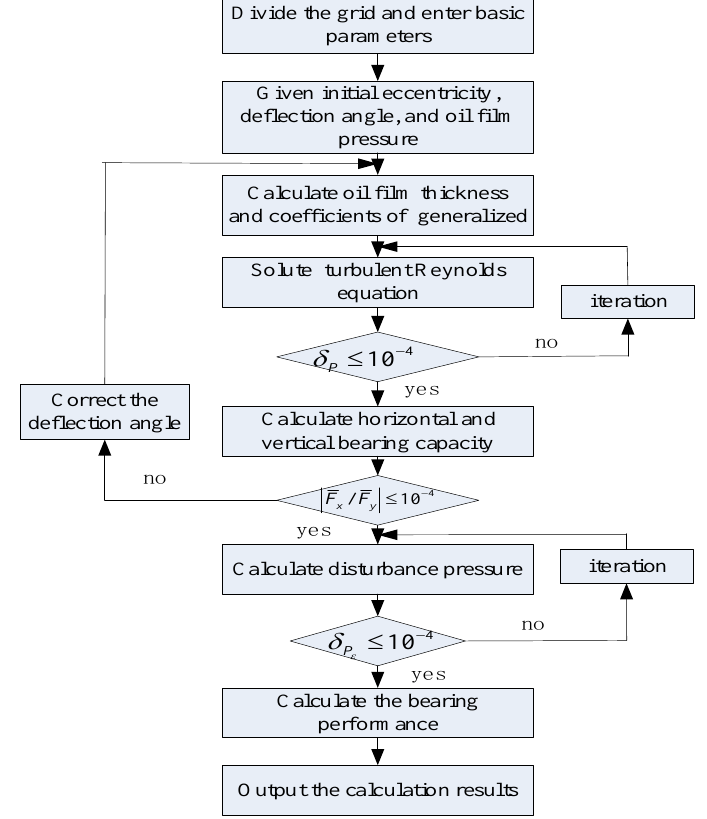
Figure 7. Performance calculation flow chart of the HGJBs.